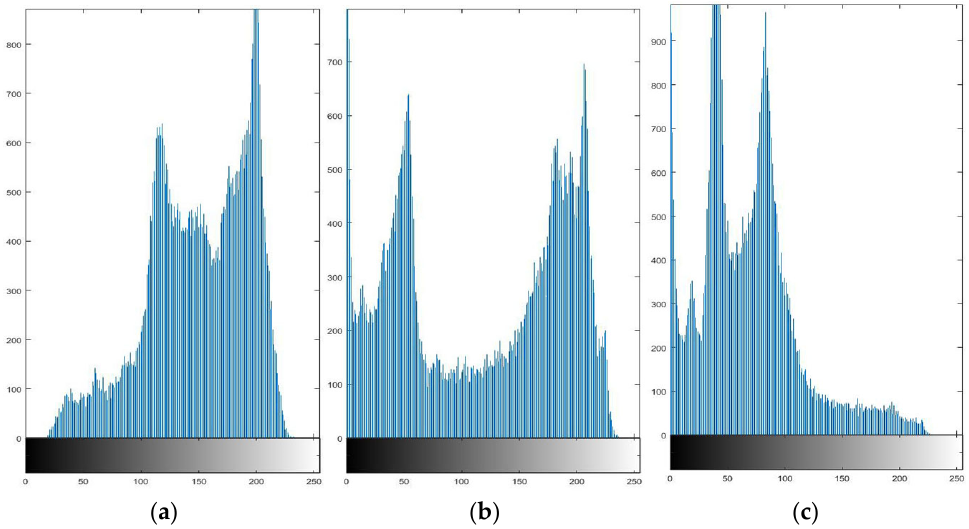
Electronics 2022 , 11 , 3436 Figure 8. RGB histogram of Lena. ( a ) Lena R ‐ channel pixel histogram; ( b ) Lena G ‐ channel pixel Figure 8. RGB histogram of Lena. ( a ) Lena R-channel pixel histogram; ( b ) Lena G-channel pixel histogram; ( c ) Lena B ‐ channel pixel histogram. histogram; ( c ) Lena B-channel pixel histogram.